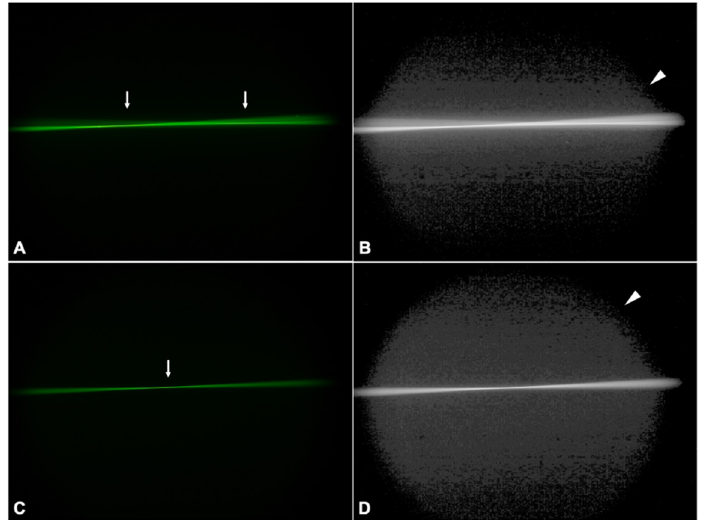
Figure 5. Ray propagation and light scattering of the calcified LS-312 MF30 ( A , B ) and Euromaxx ( C , D ) IOL-explants. The arrows indicate the focal point, while the arrowheads point to the scatter light.